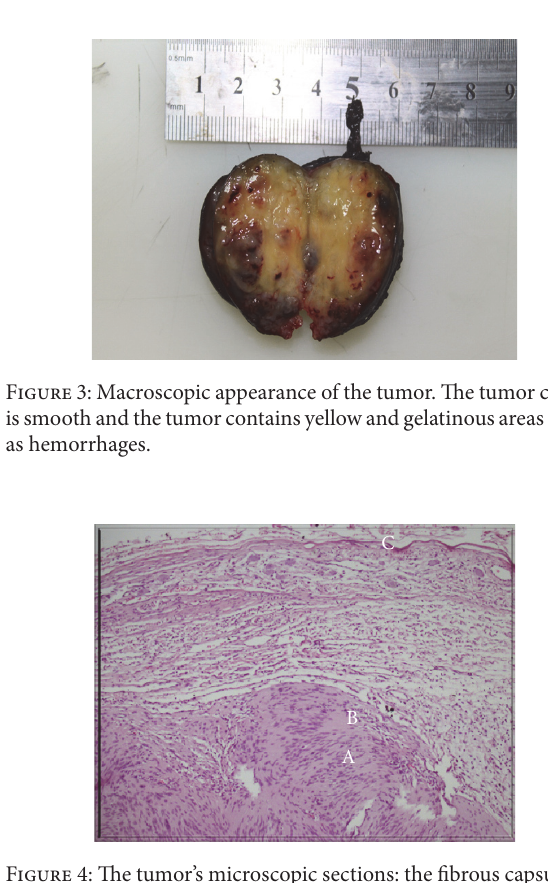
Figure 2: A solid mass (white arrow) 35 × 37 mm in diameter was identified in the left adrenal region in magnetic resonance imaging.